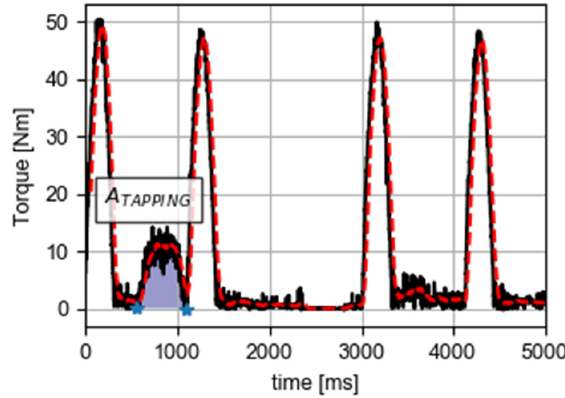
Figure 7. Torque signals of first acceptable threads and the main area feature (A TAPPING ) to characterize the threading process.